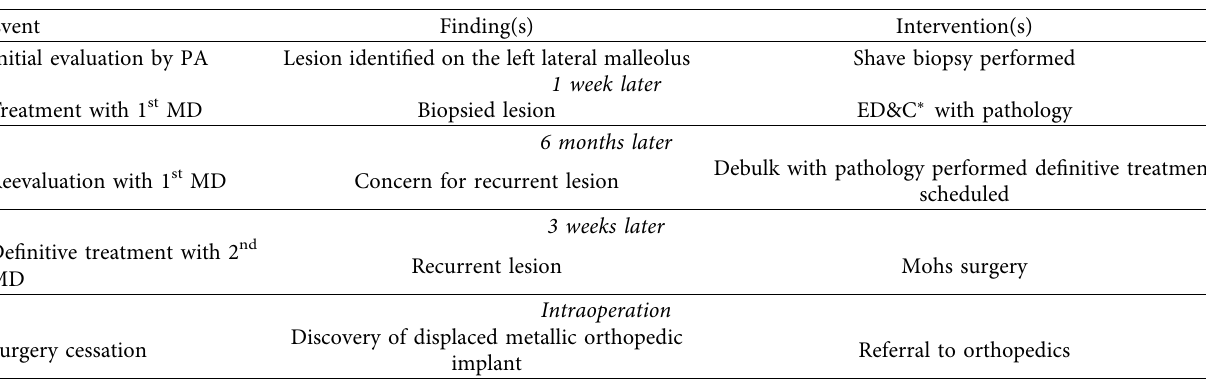
Figure 2: Histopathological imaging from initial biopsy (a) and 6-month recurrence (b). Papillomatous and endophytic squamous proliferation is present with keratin plug, parakeratin, and mild pleomorphism of keratinocytes extending to the base of the biopsy (a). 6months later, the biopsy showed overlying thickened parakeratin alternating with parakeratin with serum accumulation (b). Collections of neutrophils were also observed in the stratum corneum (b), so a PAS stain was performed to evaluate for the presence of fungal organisms. No fungal organisms were noted. The adjacent epidermis displayed acanthosis and papillomatosis composed of suprabasilar keratinocytes without significant atypia (b). Table 1: Timeline of